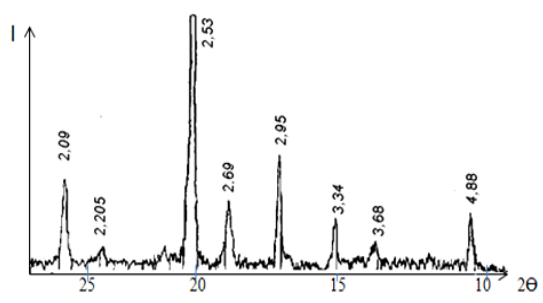
Fig. 4. X-ray diffractogram of Kharganat iron ore